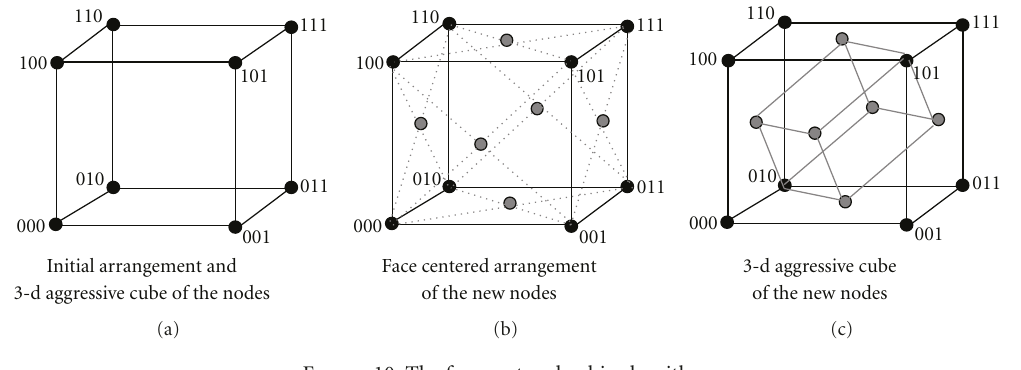
Figure 10: The face centered cubic algorithm.